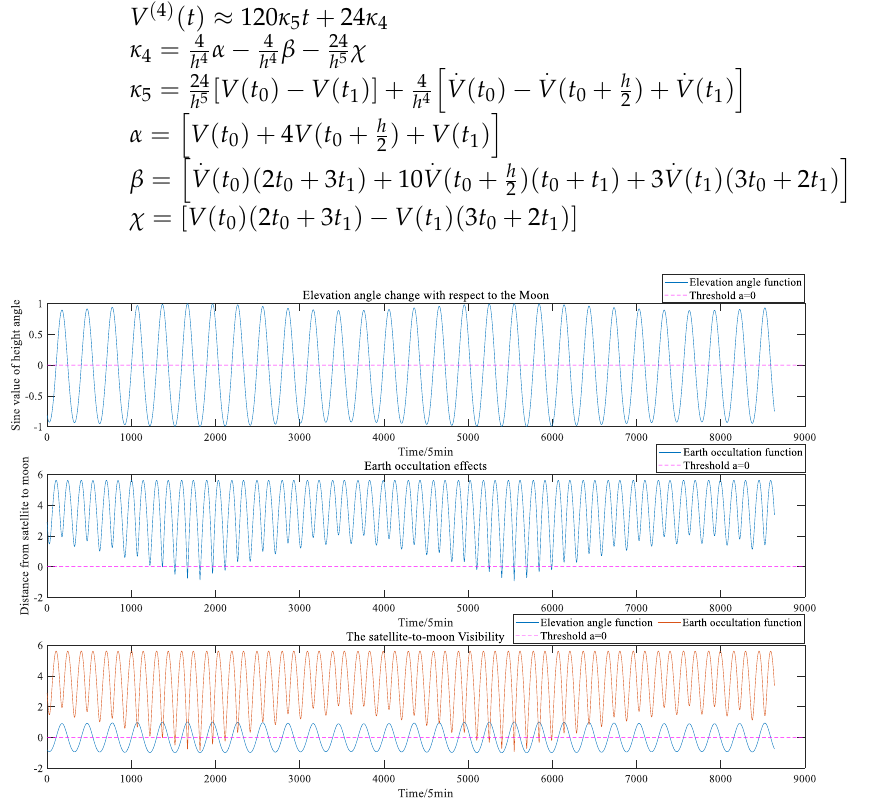
Figure 2. Visibility image of the C01 GEO satellite.